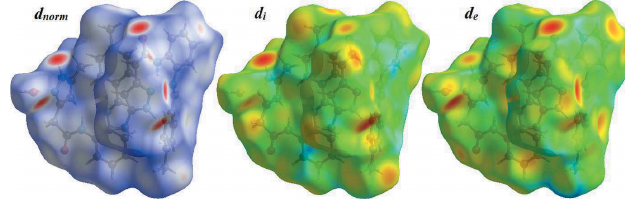
Figure 5 The Hirshfeld surface of the title compound mapped over d norm , d i and d e